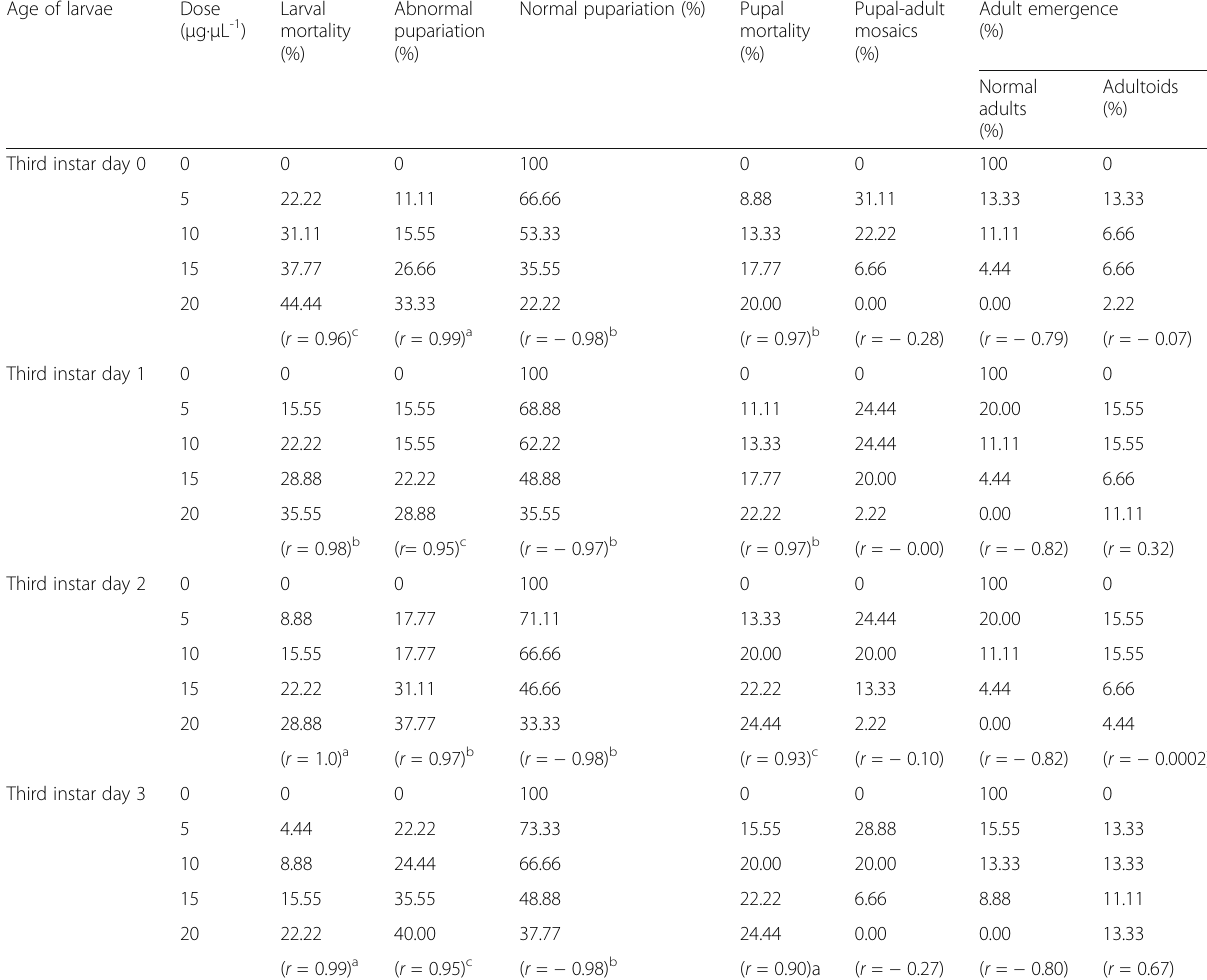
Table 1 Effect of topical administration of root extracts of Withania somnifera to third instar day 0 – 3 larvae of Sarcophaga ruficornis ( n = 15; replication =